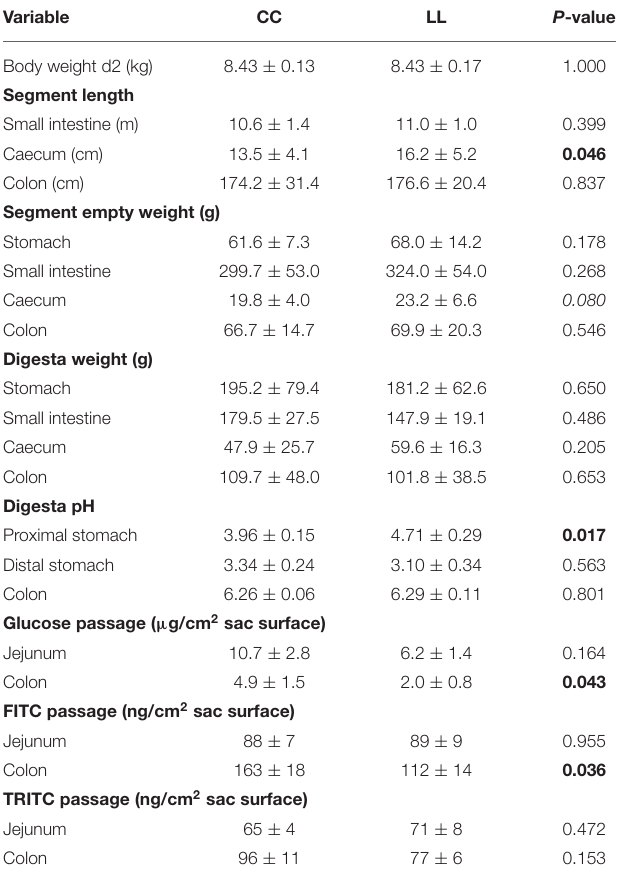
TABLE 7 | Post-mortem gastro-intestinal tract measures on d3 post-weaning. Variable